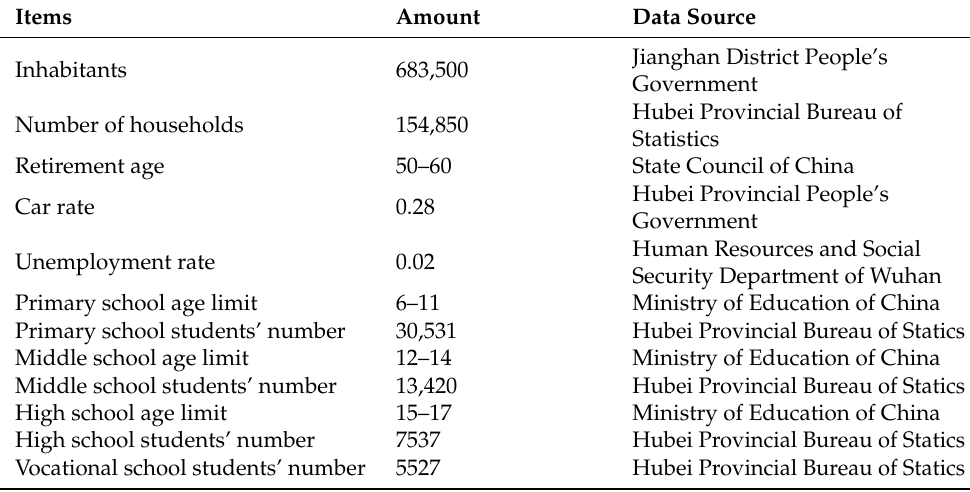
Table 1. Information for generating traffic demand in